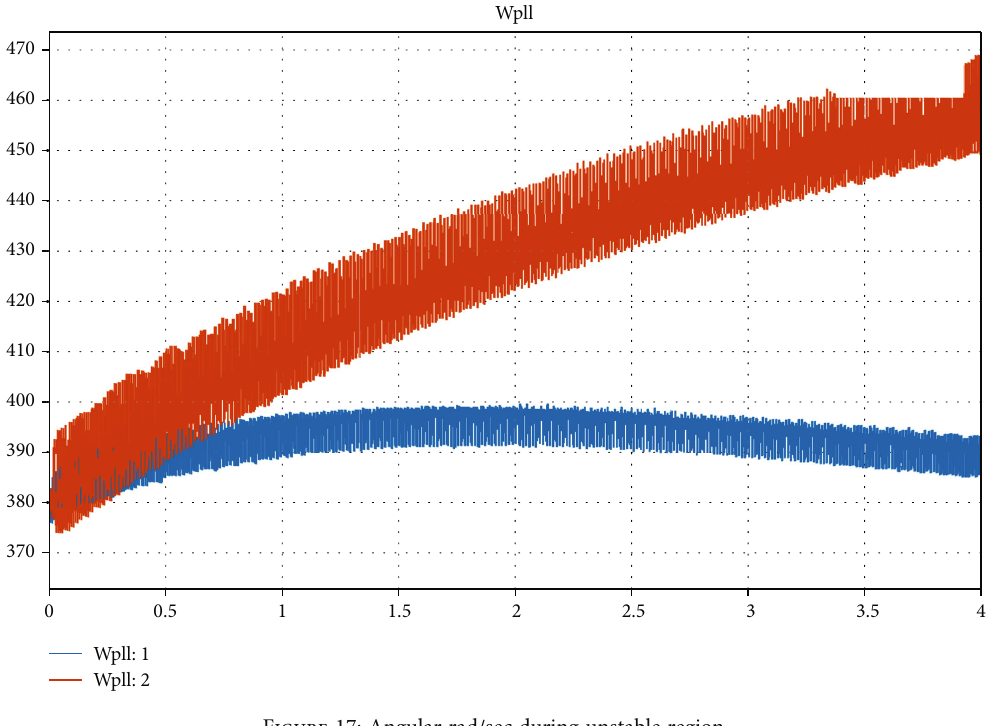
Figure 17: Angular rad/sec during unstable region.